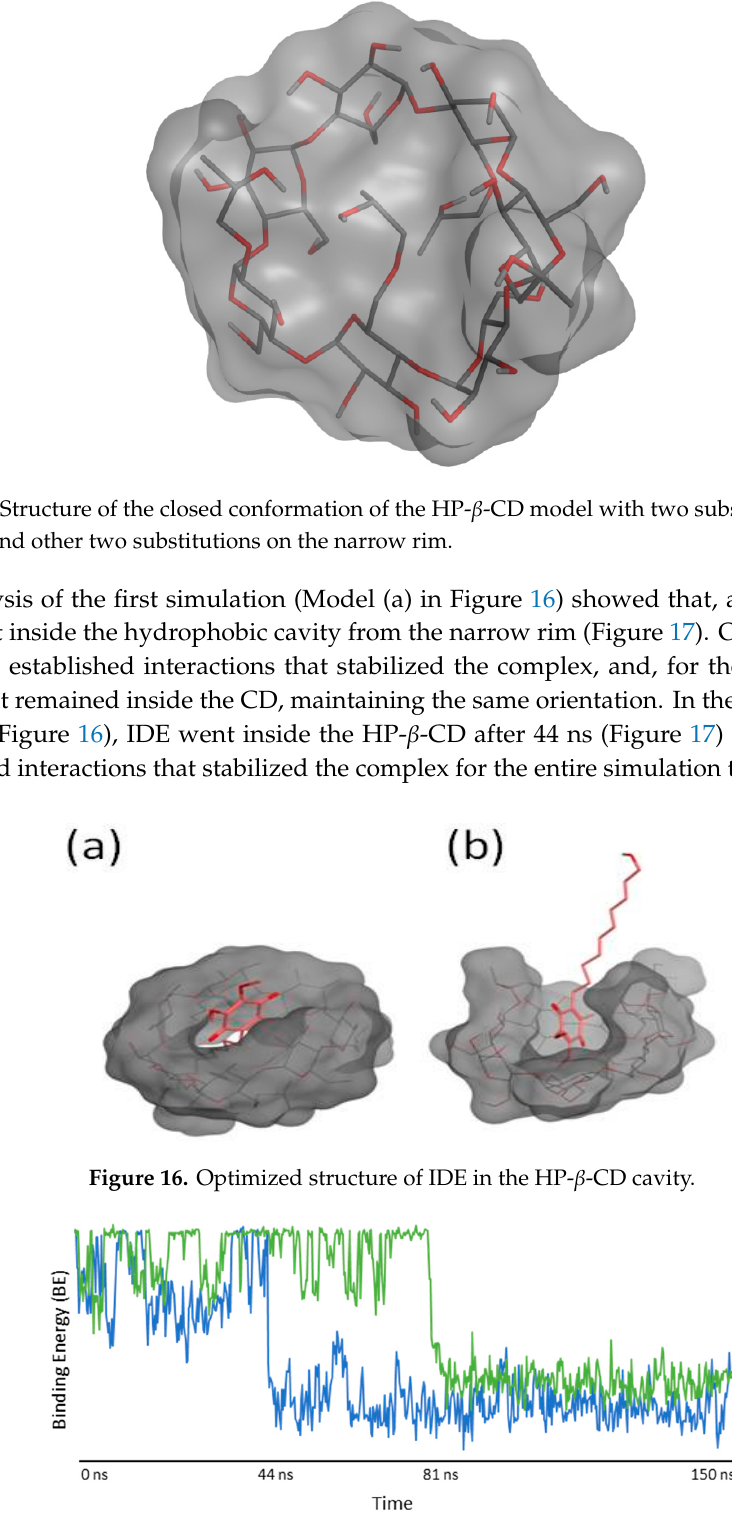
19 of 28 Figure 14. On the left: 2D diffusion ordered spectroscopy (DOSY)-NMR measurements on the 14 mM aqueous methanol solutions (D 2 O/CD 3 OD 1:1) of the IDE, HP- β -CD, and IDE/HP- β -CD inclusion complex. The horizontal axis represents the chemical shifts; the vertical axis represents the diffusion coefficients. The black spots are the resonances of the aqueous solution of the inclusion complex spread in the second dimension according to their measured diffusion coefficient. On the right: enlarged representation of the red box. 3.3. Molecular Modeling Studies In order to investigate the IDE/HP- β -CD host–guest interactions, we started the molecular modeling study with a molecular dynamics (MD) simulation. Two different MD simulations were carried out using different HP- β -CD. In the first one, four oxygens on the C 2 position (residues 1, 3, 5, and 7) were substituted with the 2-hydroxypropyl group; in the second one, the four oxygens on